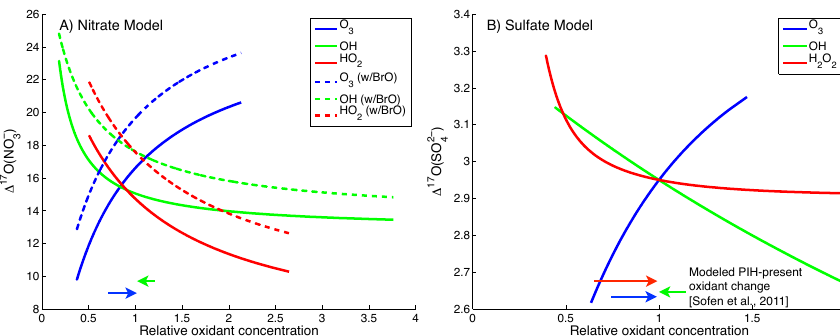
Figure 5. Sensitivity of (A) 1 17 O ( NO 3 − ) and (B) 1 17 O ( SO 42 − ) to variations in each oxidant, normalized to the mean oxidant concen- trations ( = 1.0) of the present-day South American and Southern Ocean boundary layers, respectively. Dashed lines indicate results when 1pmolmol − 1 BrO is include as both an oxidant of NO in NO x cycling and as an oxidant of NO 2 , which leads to nitrate formation via the hydrolysis of BrONO 2 . Arrows at the bottom indicate the fractional change in oxidant abundances over the Southern Ocean between preindustrial Holocene and present-day chemical transport model simulations (Sofen et al., 2011) for